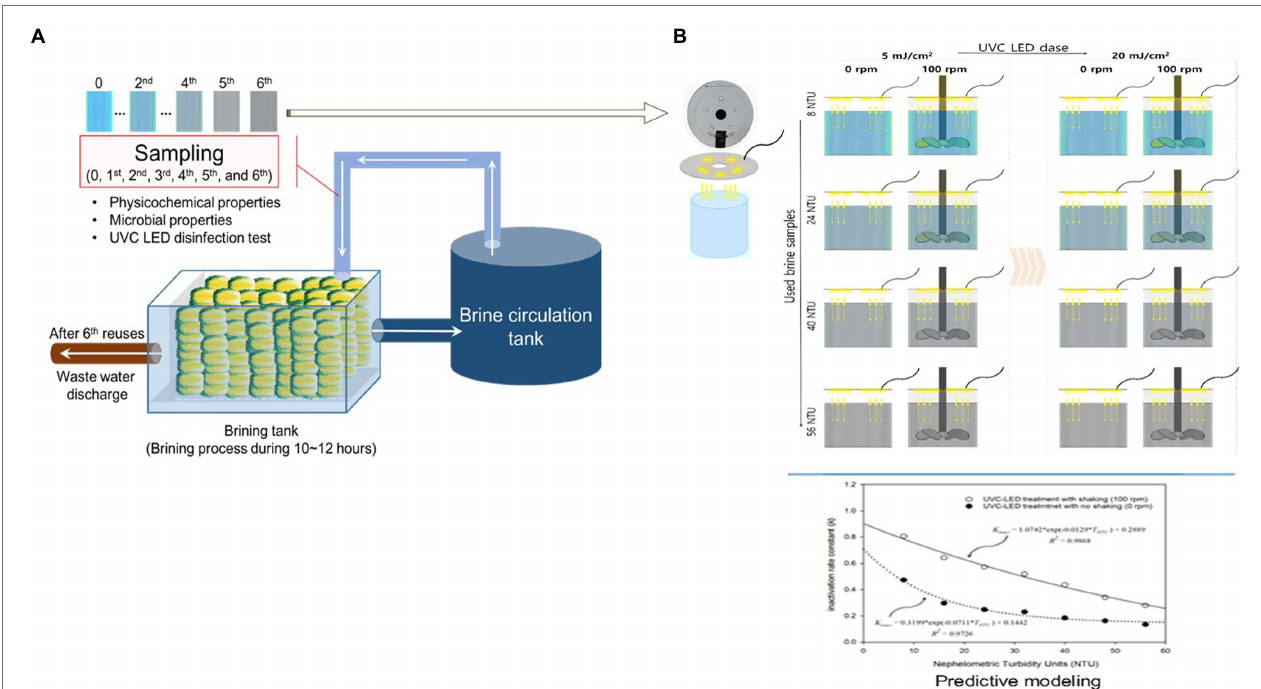
FIGURE 1 | Schematic diagram of (A) manufacturing process for brining cabbage and (B) the UVC LED-treatment in conjunction with the impeller system for disinfection of used brine water